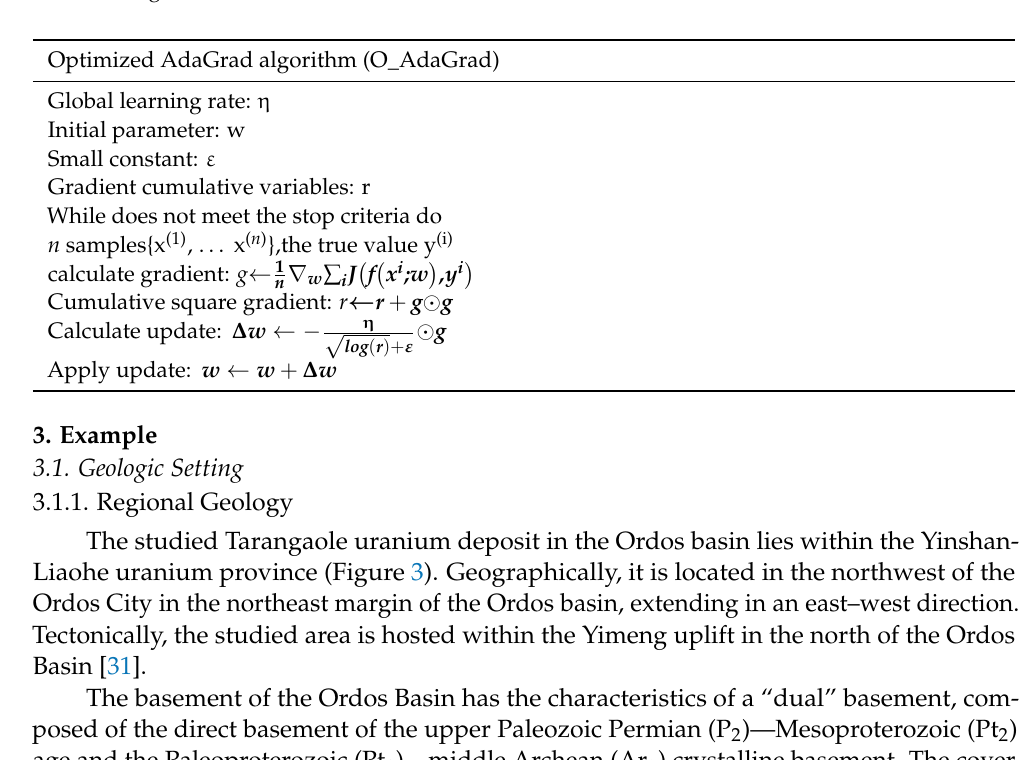
Figure 2. ( a ) The gradient descent of AdaGrad algorithm; ( b ) The optimized gradient descent of AdaGrad